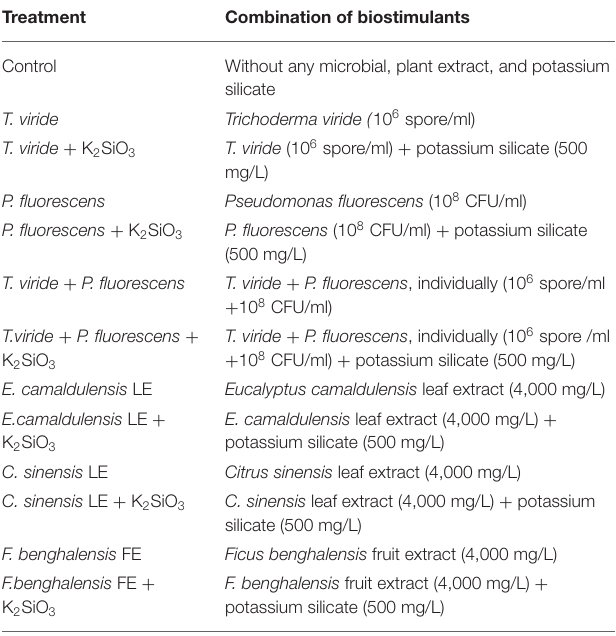
TABLE 1 | Treatments used in this